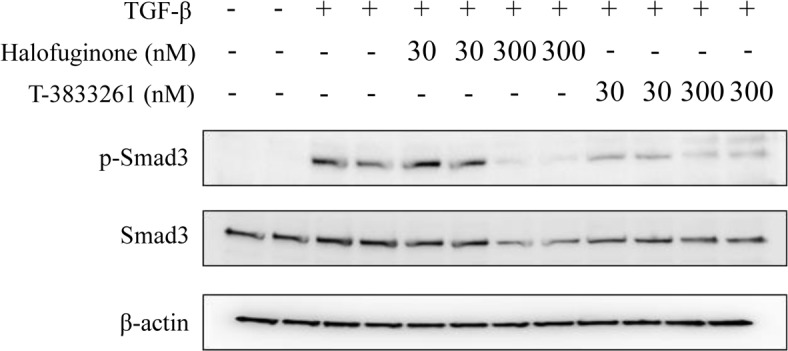
Effect of T-3833261 or Halofuginone on Smad3 protein expression in human skin fibroblasts.Representative western blots show that Halofuginone or T-3833261 reduces Smad3 and phosphorylated Smad3 (p-Smad3) protein expressions significantly. β-actin shown as simultaneous loading controls. The data of this experiments were repeated three times.